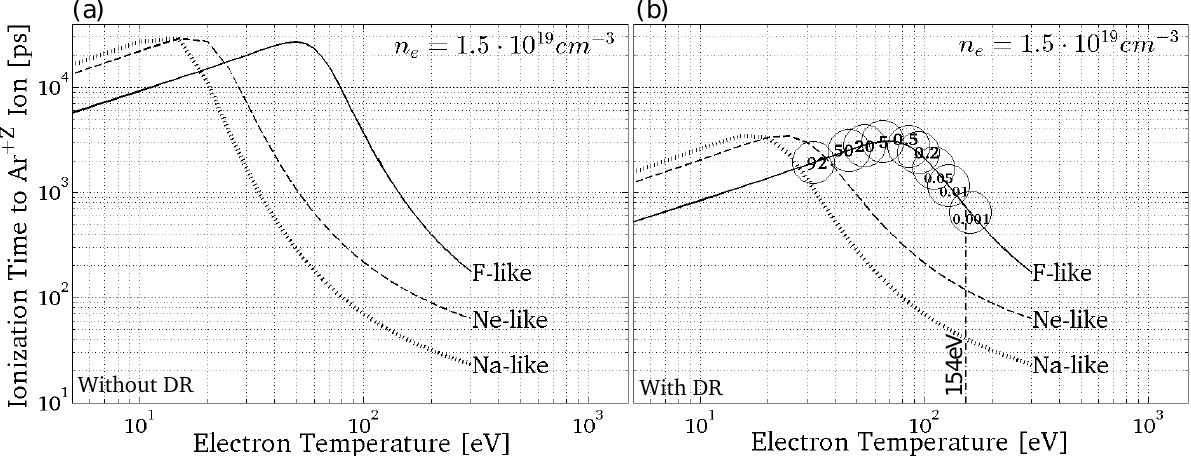
Figure 3. Time required to achieve the Ar + Z ion for the following steps: (i) Ar +6 → Ar +7 (Na-like); (ii) Ar +7 → Ar +8 (Ne-like); and (iii) Ar +8 → Ar +9 (F-like); as a function of = 1 . 5 · 10 19 cm − 3 . The ionization time without temperature at a constant electron density n e ( a ) and with ( b ) taking the dielectronic recombination (DR) into consideration is shown. The ionic fractions of Ar +8 at each specific electron temperature are given on the curve Ar +8 → Ar +9